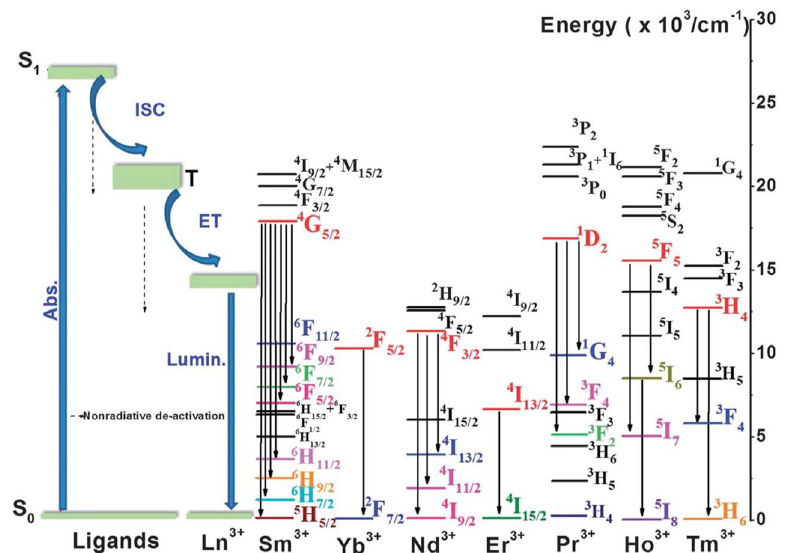
Figure 2. Photosensitization process and 4f energy level diagrams of some rare-earth ions. Reprinted with permission from [8] © 2013 Royal Society of Chemistry. (Abs is absorbing. ISC is intersystem crossing. T is the triplet state. ET is the energy transfer.).